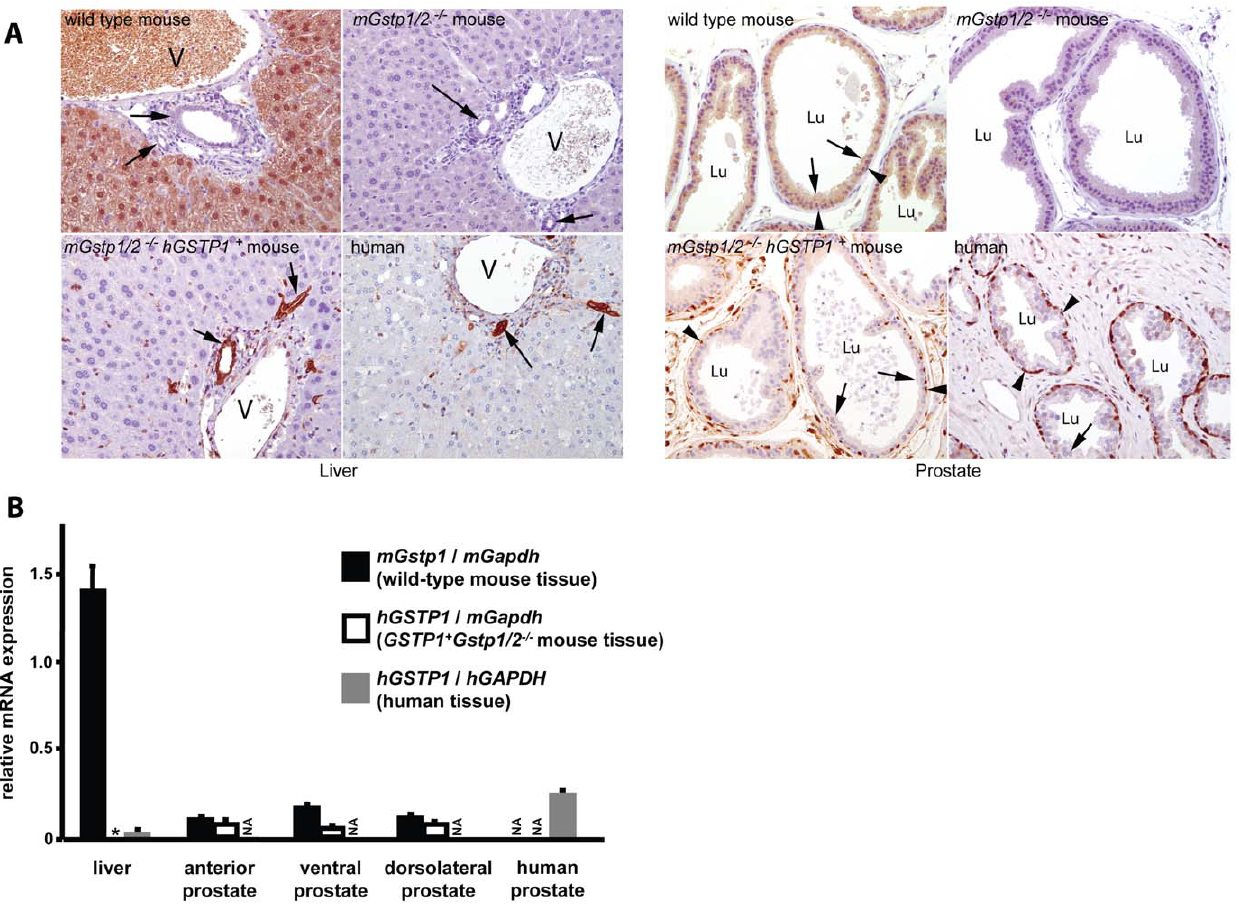
Figure 2. Regulation of p -class GST expression in hGSTP1 + mGstp1/2 2 / 2 mice. (A) Immunohistochemistry using anti-GST p antibodies for liver and prostate tissues from a wild type mouse, mGstp1/2 2 / 2 mouse, hGSTP1 + mGstp1/2 2 / 2 mouse, and human. Left panels show liver staining; arrows, bile ducts; V, central vein. Right panels show prostate staining, arrows, representative luminal cells; arrowheads, representative basal cells; Lu, lumen of prostate gland acini. All images are 200 6 original magnification. (B) Quantitative RT-PCR for mGstp1 and hGSTP1 , normalized to mGapdh or hGAPDH , using RNA from various tissues.